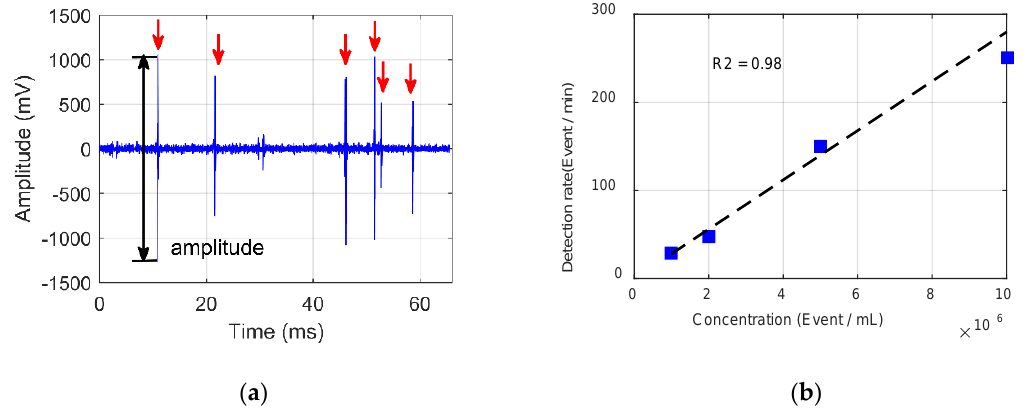
Figure 4. Particle concentration classification measurement results. ( a ) Time-domain self-mixing interferometry (SMI) signal trace. The red arrows denote the individual detection events and the black dashed lines denote the noise floor level. ( b ) The detection rate profile as a function of particle concentration. The dashed line denotes the linear fitting results.